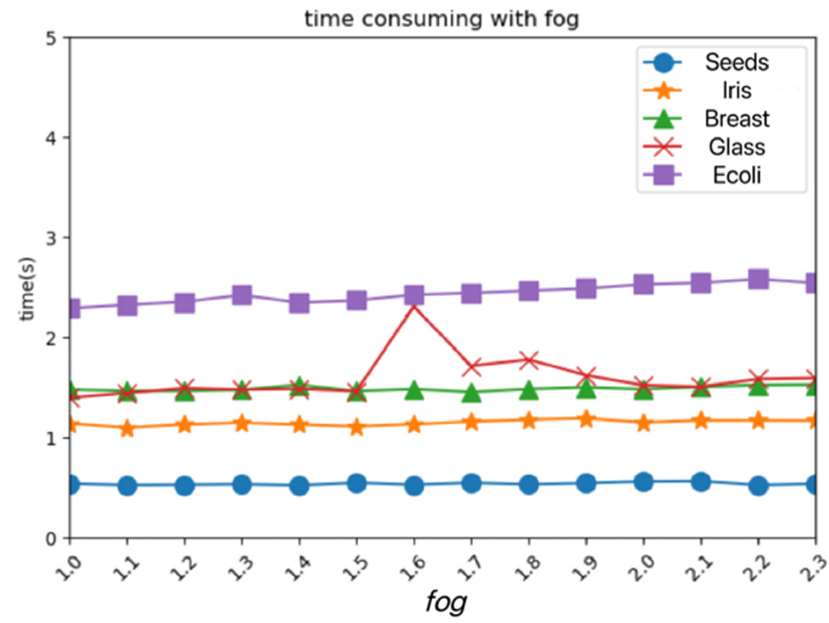
Figure 7. Parameter fog and time consumption of PRI-MFC algorithm.